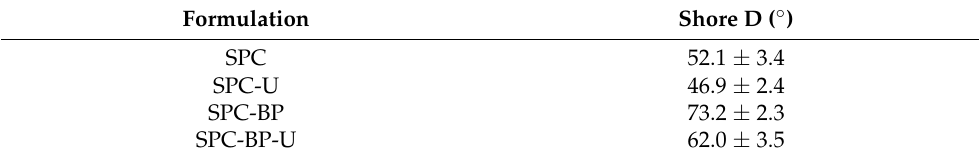
Table 6. Shore D surface hardness of the injection-molded